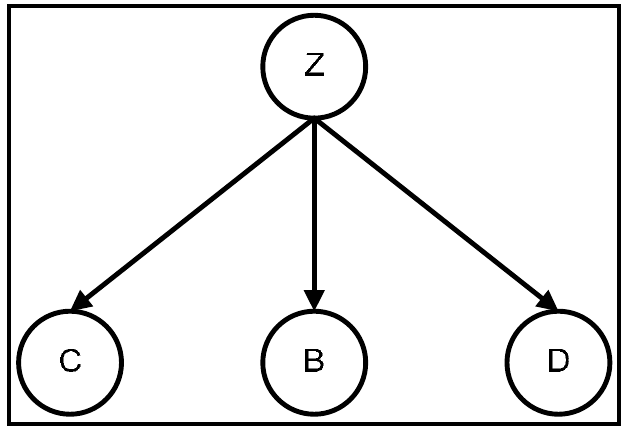
Figure 4. A Simple Static Bayesian